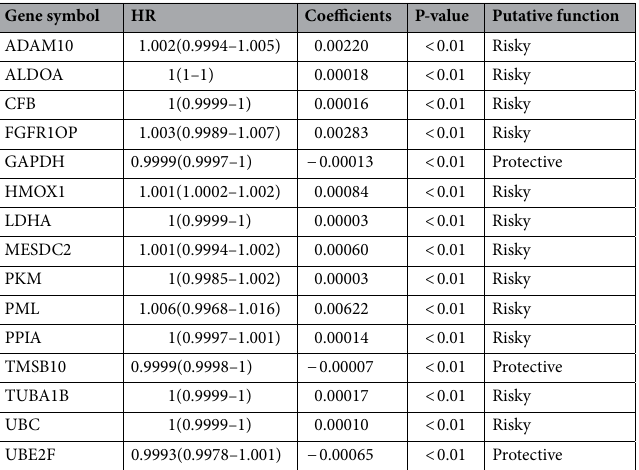
Gene symbol HR Coefficients P-value Putative